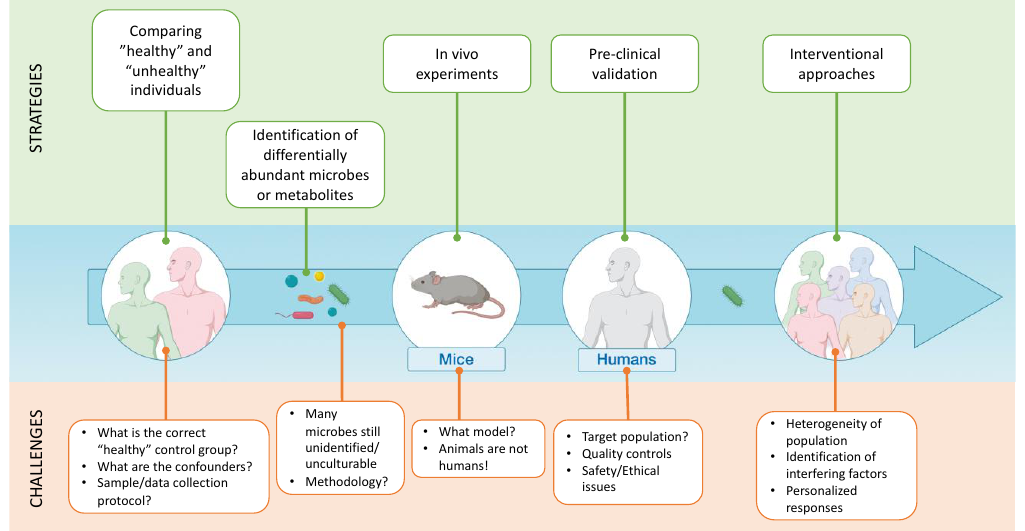
Figure 3. Challenges and strategies for establishing causality. Correlative evidence obtained from comparing healthy and diseased cohorts may identify potential beneficial bacteria or metabolites. Causality testing in animal models and humans are needed to validate the observational findings and can help decipher mechanistic or host-response effects. In very rare cases, this may lead to the development of new therapeutic approaches. Every step of this top-down strategy faces several intrinsic challenges and difficulties.